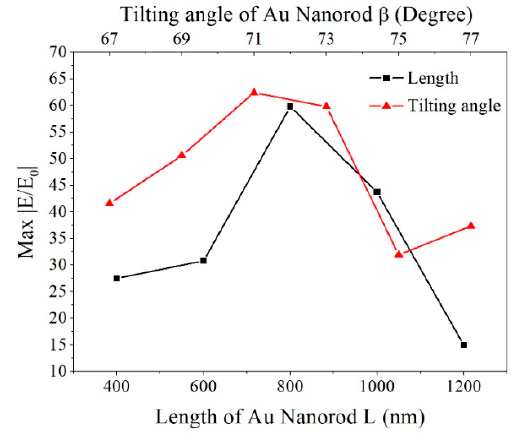
Figure 5. The electromagnetic field intensity as a function of AuNRs length and tilting angle.